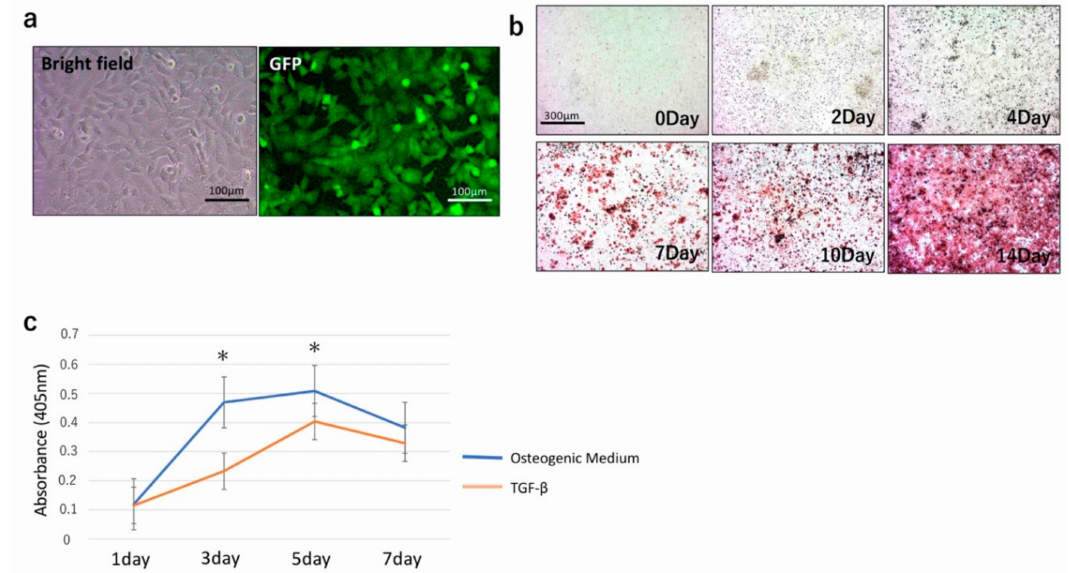
Figure 2. ( a ) TGC showed a fibroblastic shape (left), and fluorescent microscopy confirmed the expression of green fluorescent protein (GFP) (right). ( b ) Alizarin red staining of TGC exposed to osteogenic medium from 0 to 14 days. ( c ) Measurement of Alkaline Phosphatase (ALP) activity of TGC cultivated with osteogenic medium or TGF- β . The ALP activity from osteogenic medium became significantly higher than that from TGF- β at 3 and 5 days. After this point, the ALP activity of osteogenic medium- and TGF- β -exposed TGC decreased. * p <